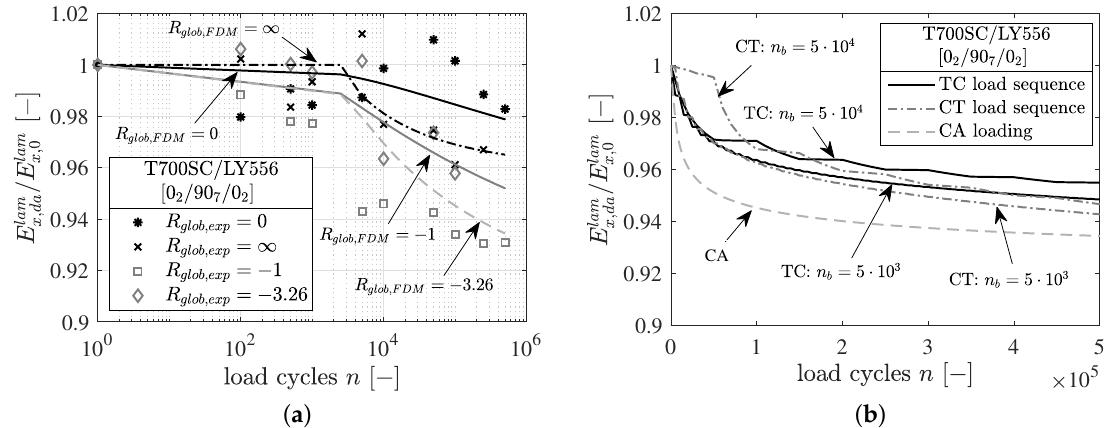
Figure 15. ( a ) Numerical prediction (subscript FDM ) and comparison with experiments (subscript exp ) of constant amplitude loading (CA) at different global stress ratios: R lam = ∞ with σ lam = − 380 MPa; ( b ) Numerical prediction of block-loading with different load and R lam min glob block length and load sequences: tension-compression sequence (TC) with n b = { 5 × 10 3 , 5 × 10 4 } and compression-tension sequence (CT) with n b = { 5 × 10 3 , 5 × 10 4 } , CA with R lam σ lam max = 105